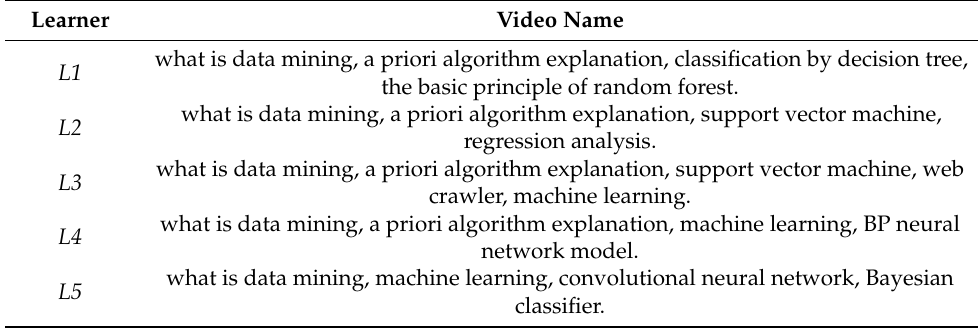
Table 1. Learner -video table.